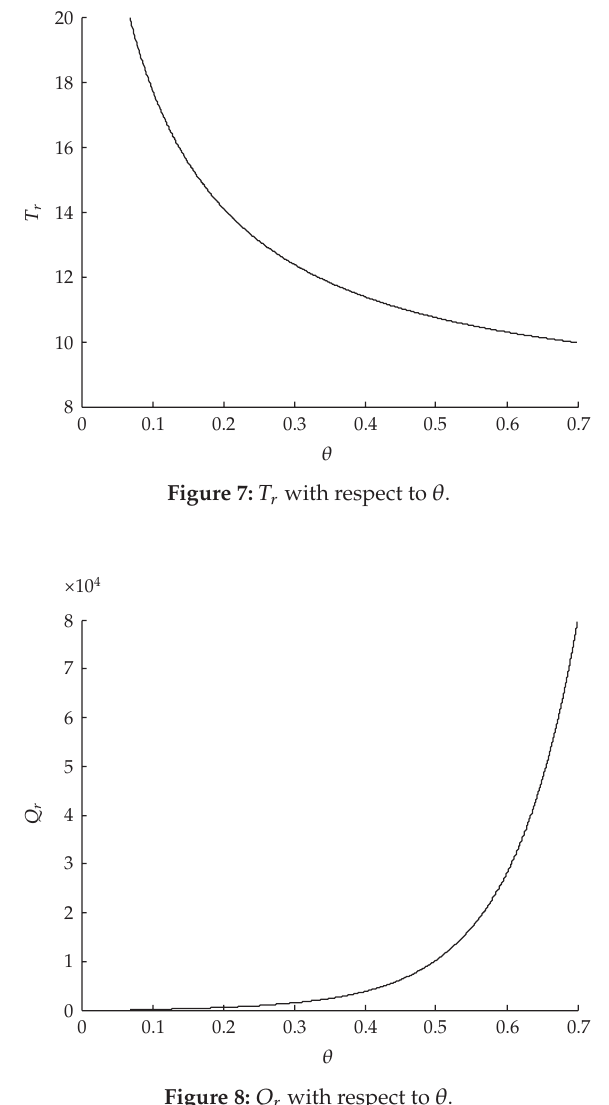
Figure 8: Q r with respect to θ